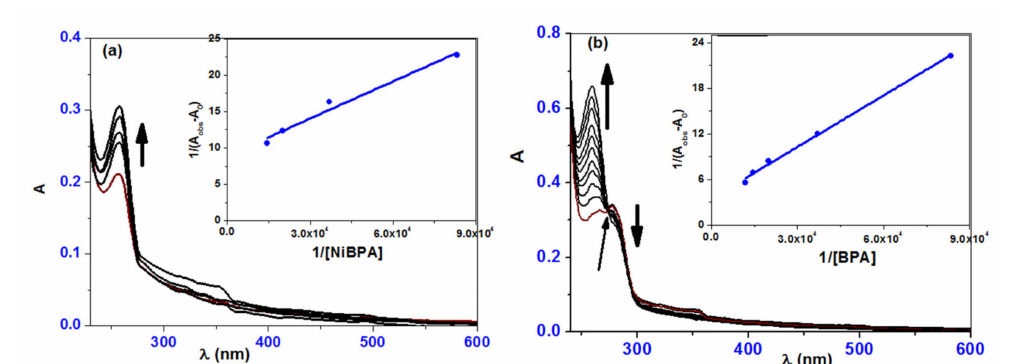
Figure 5. Plot log ( I 0 − I )/ I vs. log [Q].